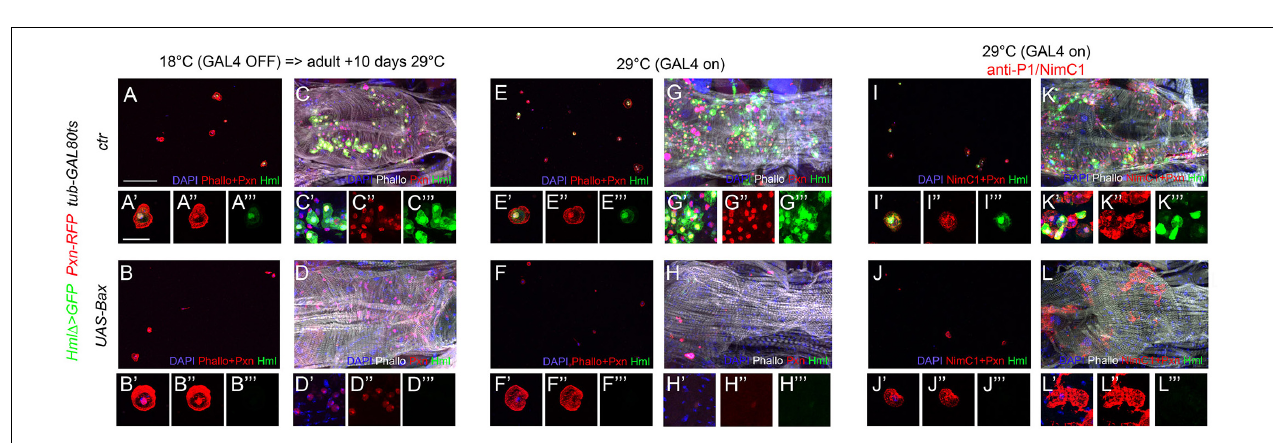
FIGURE 5 | Adult blood cells are still present following the ablation of Hml + hemocytes. Confocal views of adult bleeds (A,B,E,F,I,J) and abdominal hubs (C,D,G,H,K,L) from tub-GAL80ts, Pxn-RedStinger, Hml (cid:49) -GAL4,UAS-2xEYFP (A,C,E,G,I,K) and tub-GAL80ts, Pxn-RedStinger, Hml (cid:49) -GAL4,UAS-2xEYFP, UAS-Bax (B,D,F,H,J,L) flies expressing (or not) Bax in Hml + cells only during adulthood (A–D) or throughout their life (E–L) . Cells were stained with phalloidin ( A,B,E,F : red; C,D,G,H,K,L : white; I,J : no phalloidin) and nuclei with DAPI (blue). (I–L) : immunostaining against P1/NimC1 (red). Lower panels show high magnification views of hemocytes. (A’–L’) Merged blue, red and green channels, (A”–L”) : red channel only, (A”’–L”’) : green channel only. Upper panels: scale bar 200 µ m; lower panels: scale bar 20 µ